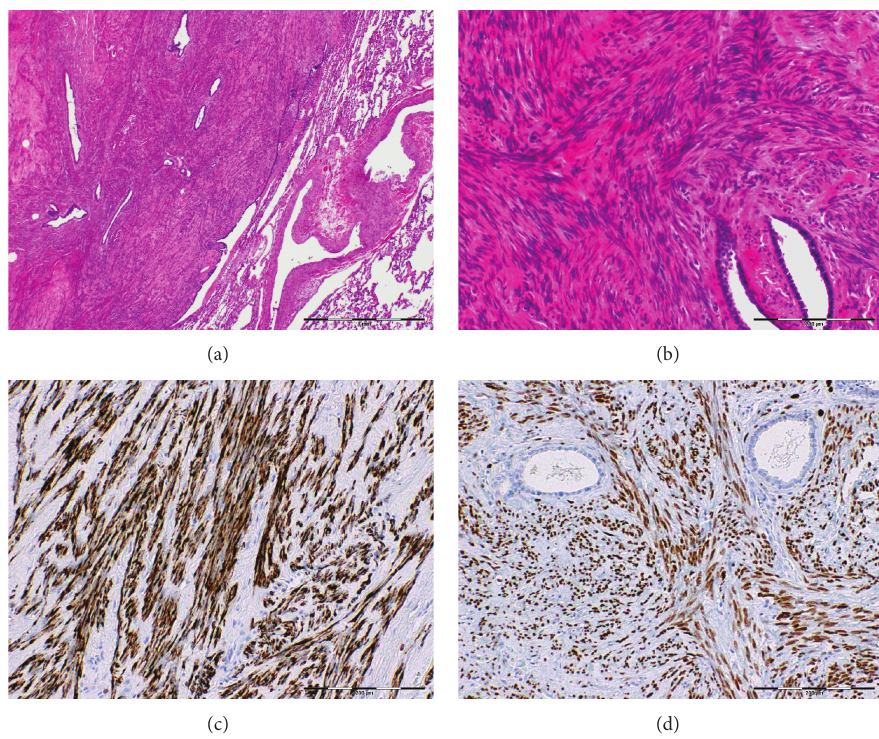
Figure 2: (a) and (b) H&E: broad fascicles of bland spindle cells with entrapped scattered tubules lined by bronchoepithelial cells. (c) and (d) Immunohistochemistry, tumor cells are strongly positive for muscular marker desmin (c) and ER (d).